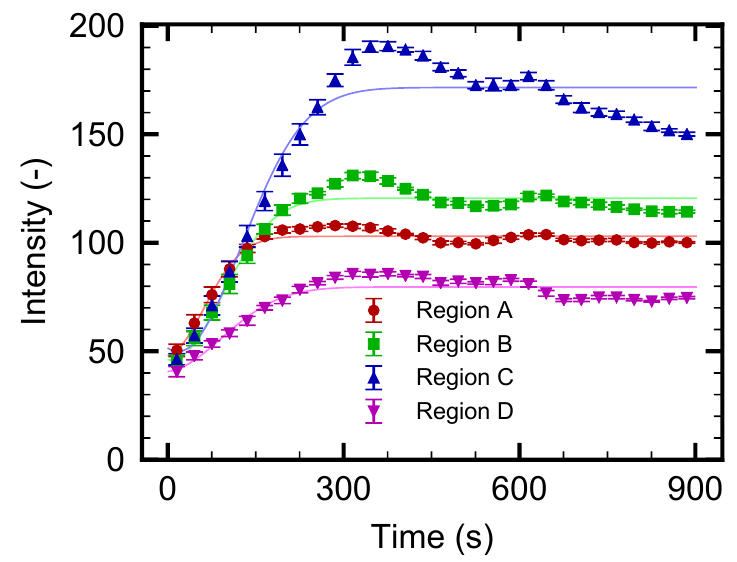
Figure 8. Time-development for fluorescence intensity of nanoparticles in regions A, B, C, and D indicated in Figure 7a. The pressure difference ∆ P is set to 0.5